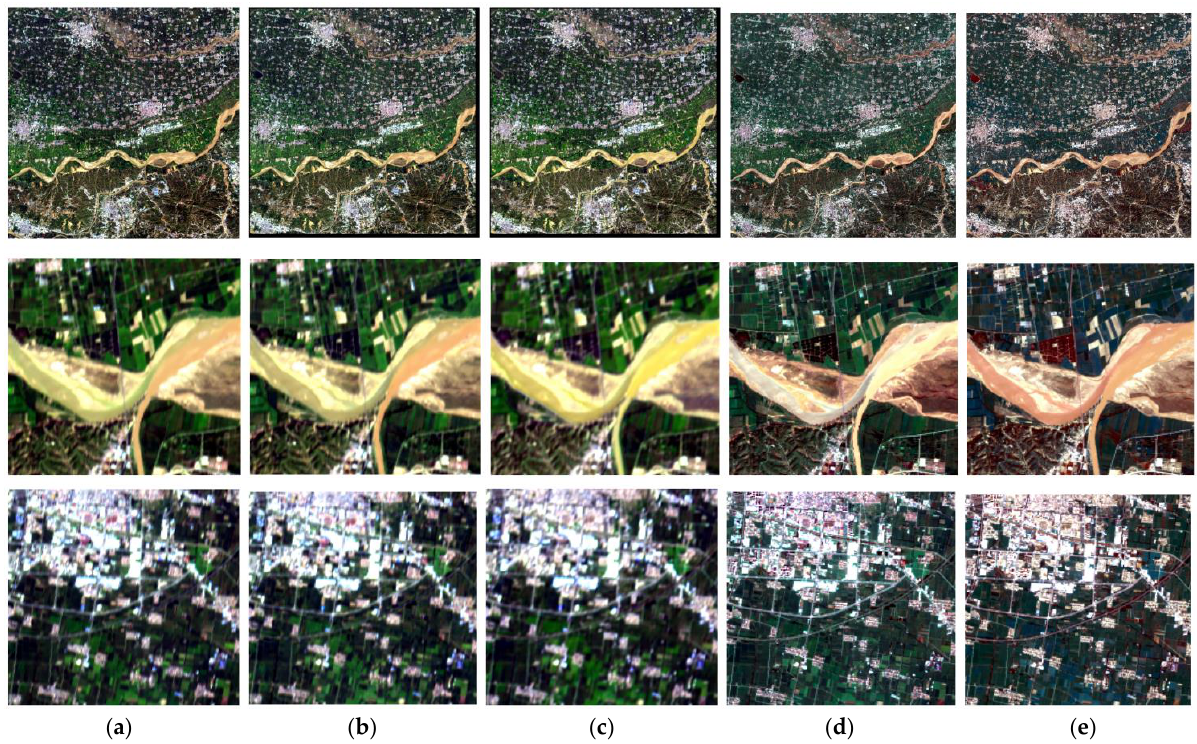
Figure 15. RGB Composites of fusion results comparison dataset I. ( a ) Original Image, ( b ) SRE-ResNet, ( c ) HSCNN, ( d ) CNMF, ( e ) J-SLoL.